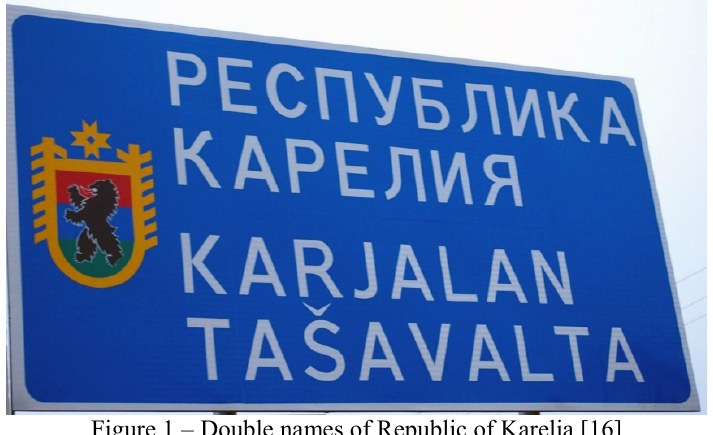
Figure 1 – Double names of Republic of Karelia [16]